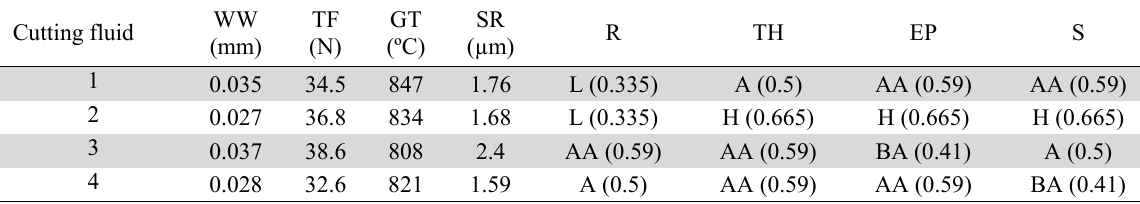
Decision matrix for case study 1 (Rao and Patel 2010) Cutting fluid